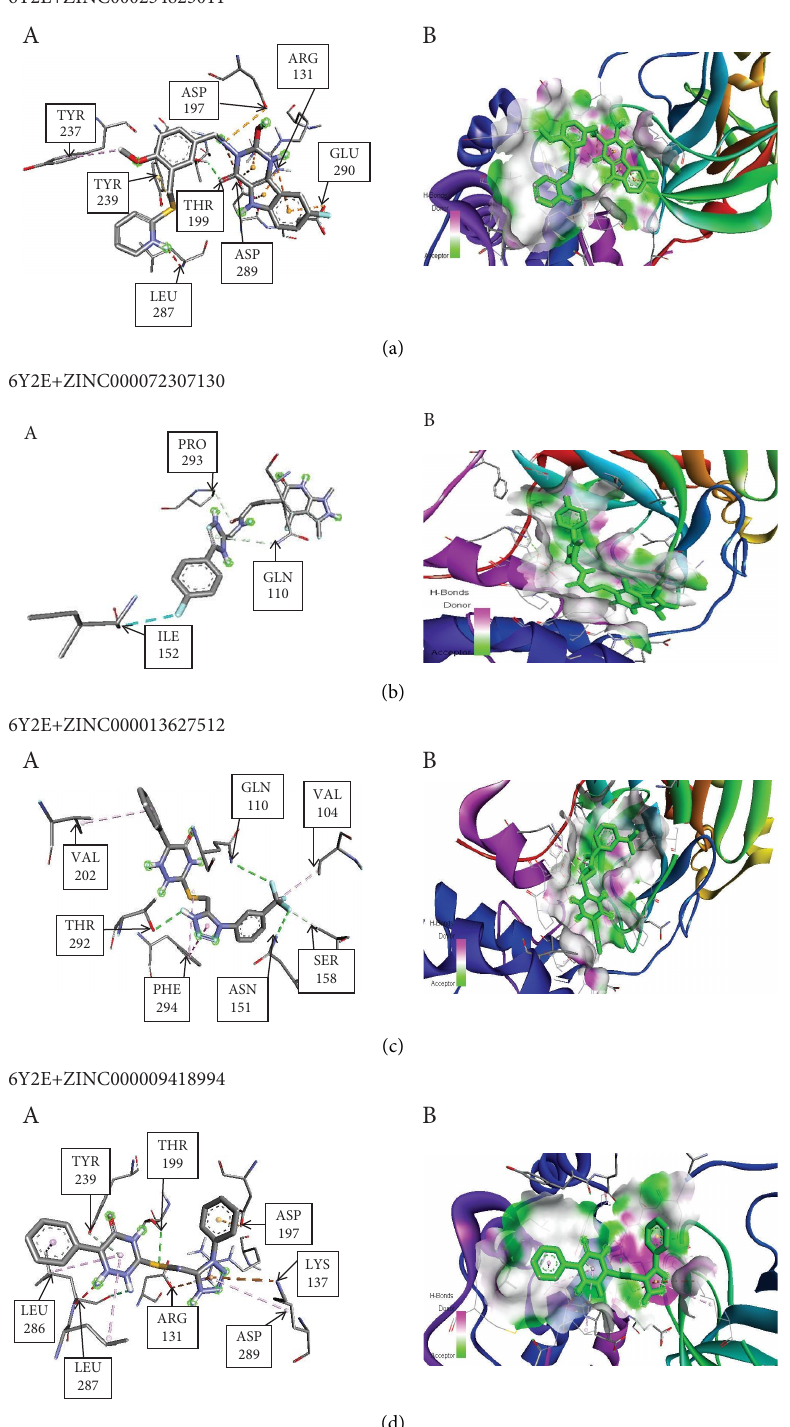
Figure 6: *e 2D interaction diagrams showing the binding site residues. (a) 6Y2E+ZINC000254823011, (b) 6Y2E+ZINC000072307130, (c) 6Y2E+ZINC000013627512 and (d)